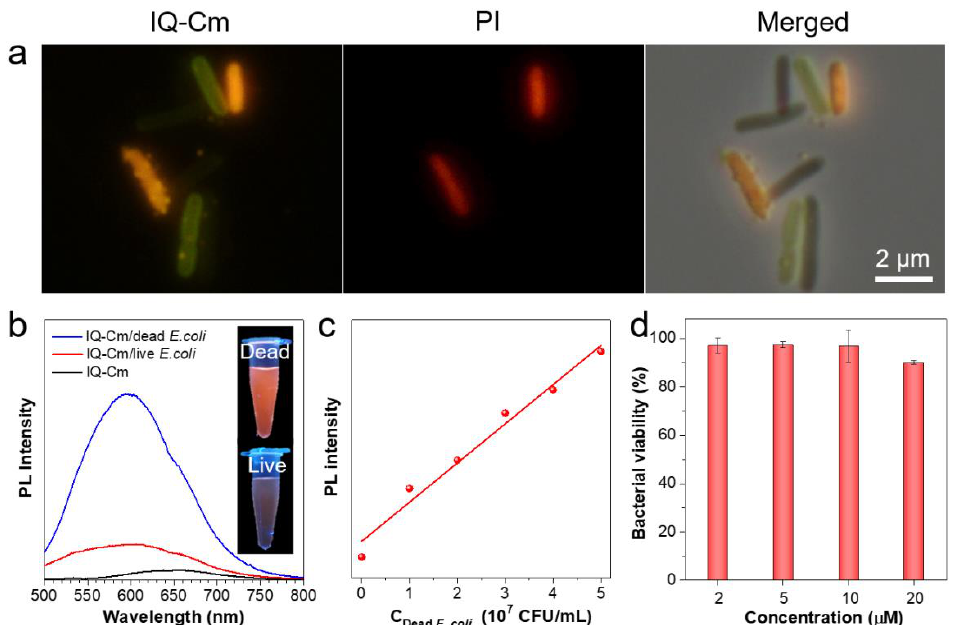
Figure 1. ( a ) Fluorescence images of E. coli incubated with IQ-Cm (10 µ M) and PI (5 µ g/mL) for 10 min. For IQ-Cm, excitation filter = 460–490 nm, dichroic mirror = 505 nm, emission filter = 515 nm long pass; for PI, excitation filter = 510–550 nm, dichroic mirror = 570 nm, emission filter = 590 nm long pass. ( b ) Fluorescence spectra of IQ-Cm (10 µ M) in PBS solution before and after the addition of live E. coli or dead E. coli. ( E. coli were killed by the treatment of 75% ethanol in water). Excitation wavelength: 450 nm. ( c ) Plot of emission intensity of IQ-Cm at 600 nm in the presence of various concentrations of dead E. coli in PBS solution. ( d ) The viability of E. coli stained with different concentrations of IQ-Cm.